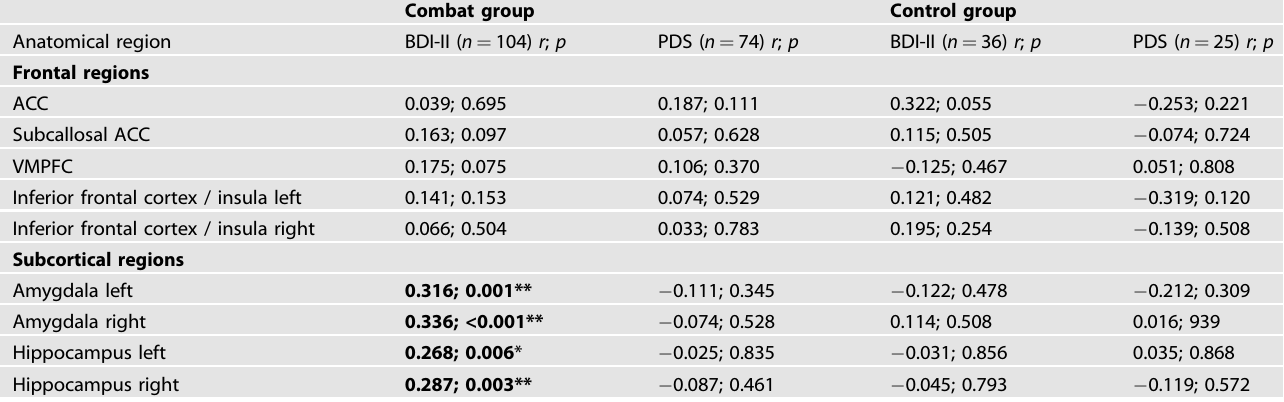
Table 2. Correlational analysis between imaging parameter estimates from the interaction group x time per anatomical region (sorted by frontal and subcortical regions) and the self-report questionnaires BDI-II and PDS for each